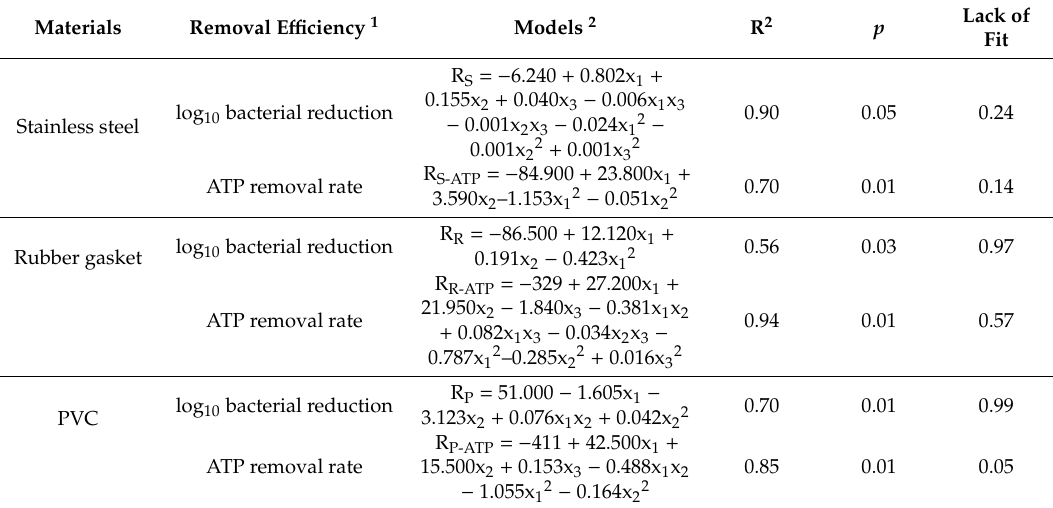
Table 5. Response surface models for log 10 bacterial reductions and ATP removal rates for three typical materials in a milking system cleaned using